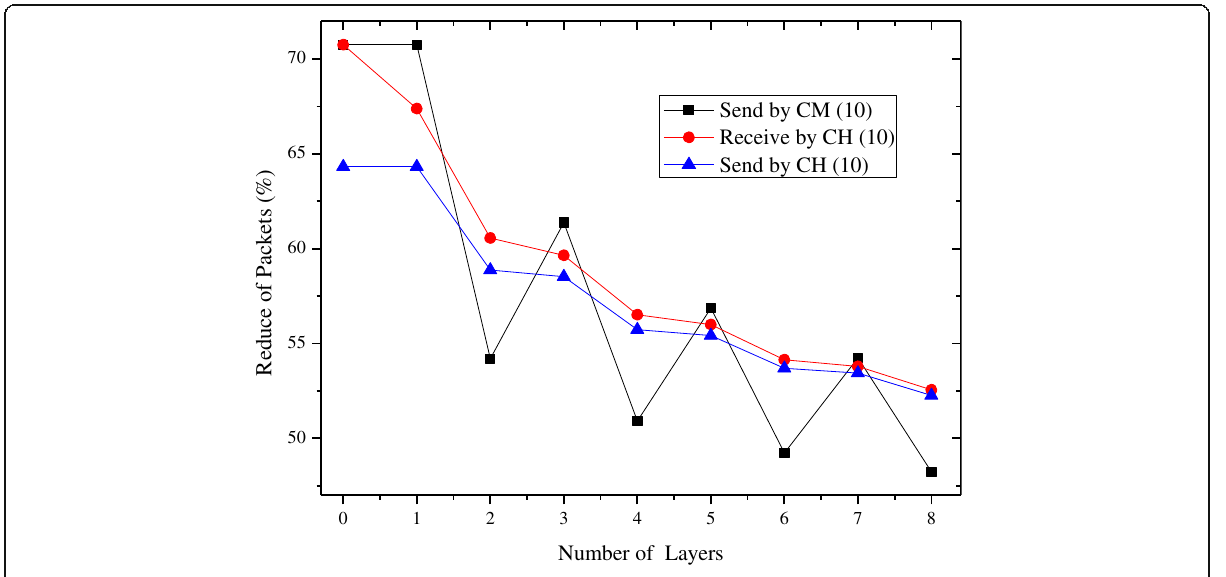
Fig. 8 The reduced percentage of the number of packets